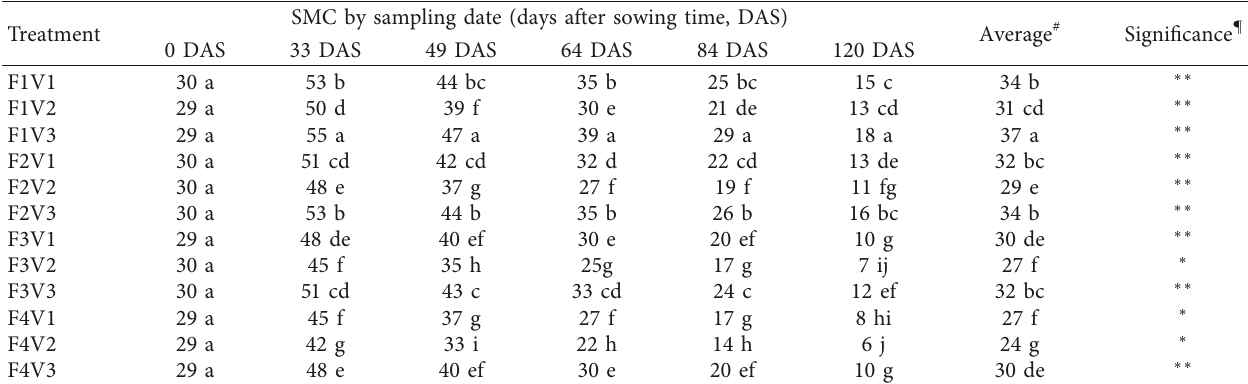
Values within a column with different letters are significantly different at the probability level ( P ) ≤ 0.05. ∗∗ Significant at P � 0 . 01; ∗ significant at P � 0 . 05. # Mean of all sampling dates for each of the treatment combined effects. { Significant level tested for the combined effects on SMC determined across the